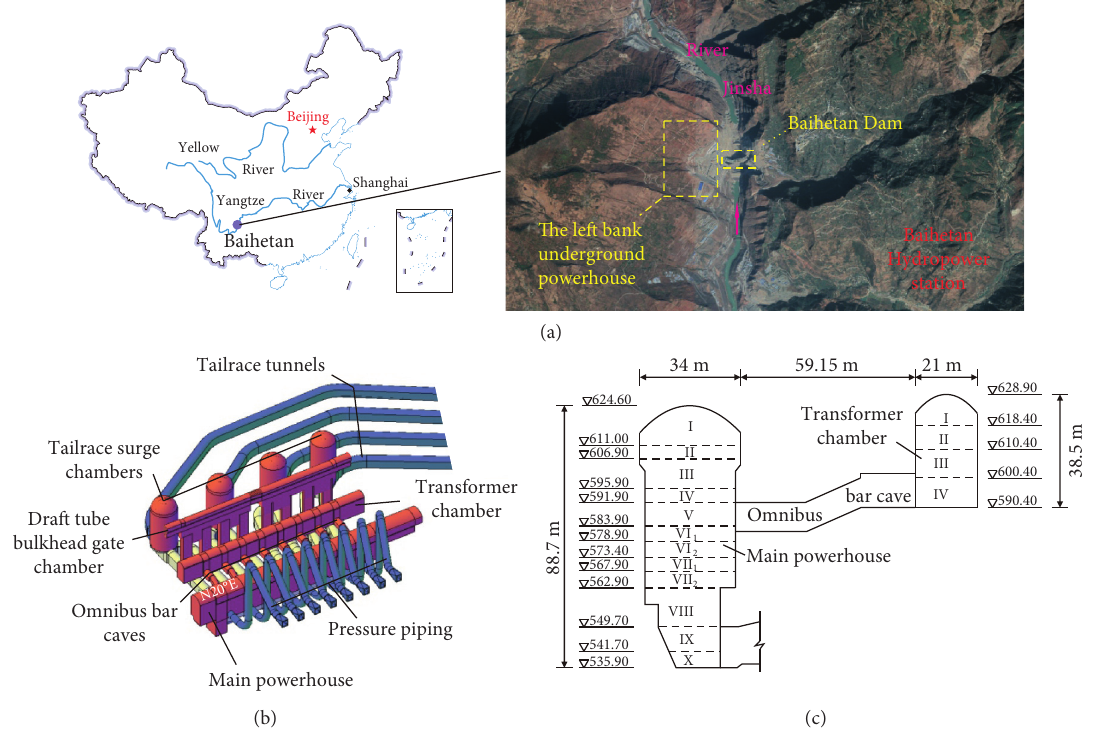
Figure 1: Site location and three-dimensional visualization of the Baihetan underground powerhouse and excavation layering diagram: (a) locations of the Baihetan Hydropower Station; (b) three-dimensional visualization of the left bank underground powerhouse; (c) a layered excavation diagram of the main powerhouse and transformer chamber (I-X refer to the layer